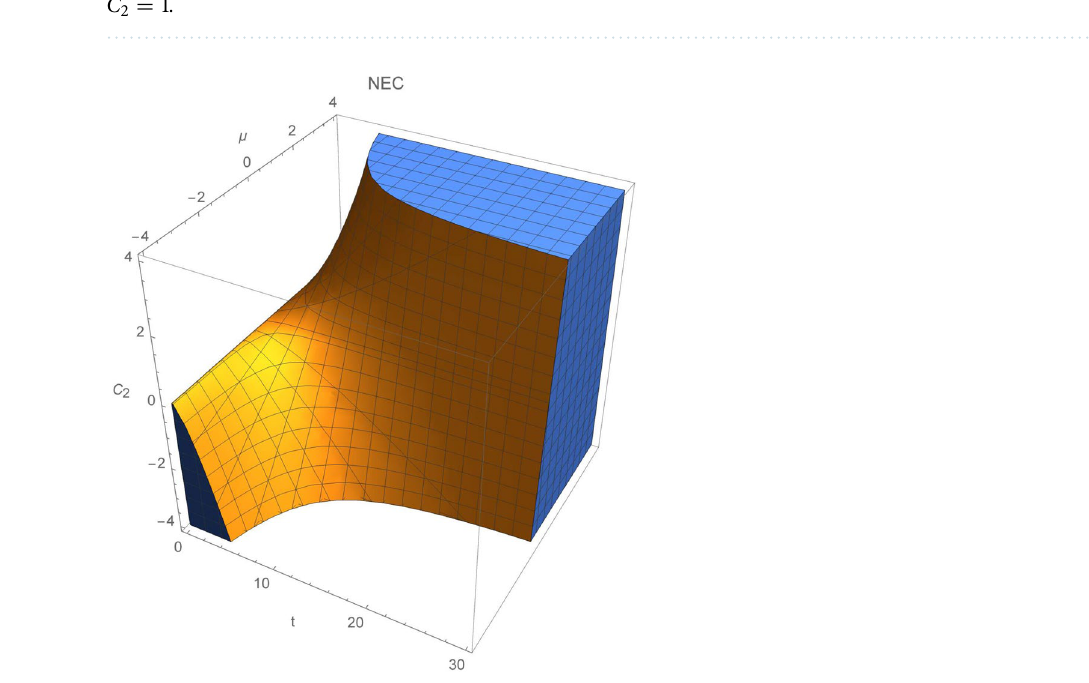
P eff and ρ eff for varying constant µ , where ρ eff +